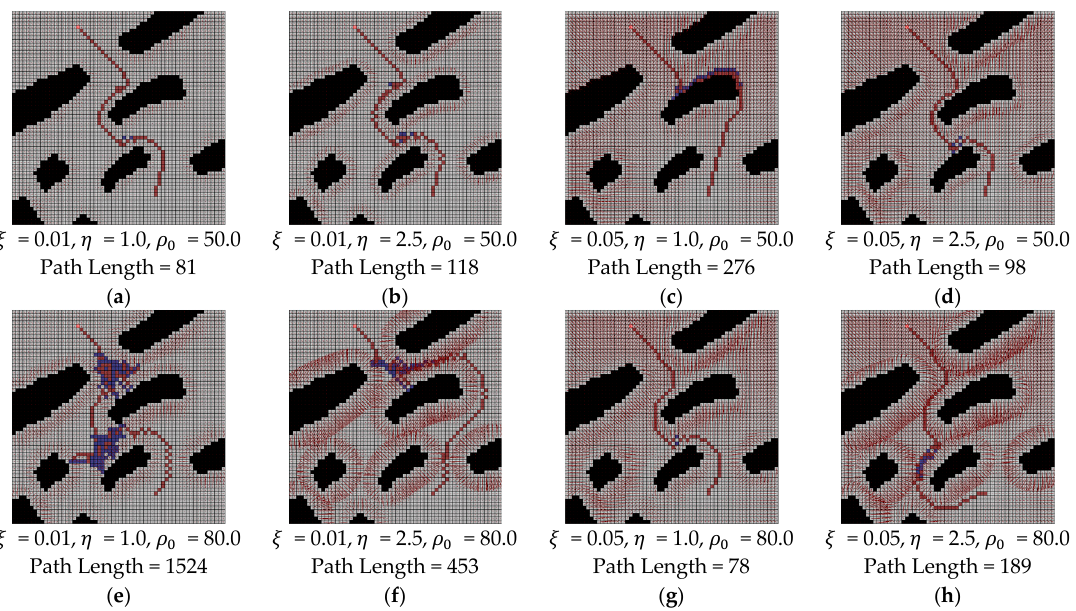
Figure 20. The results of potential field method using random walk with parameter variations.